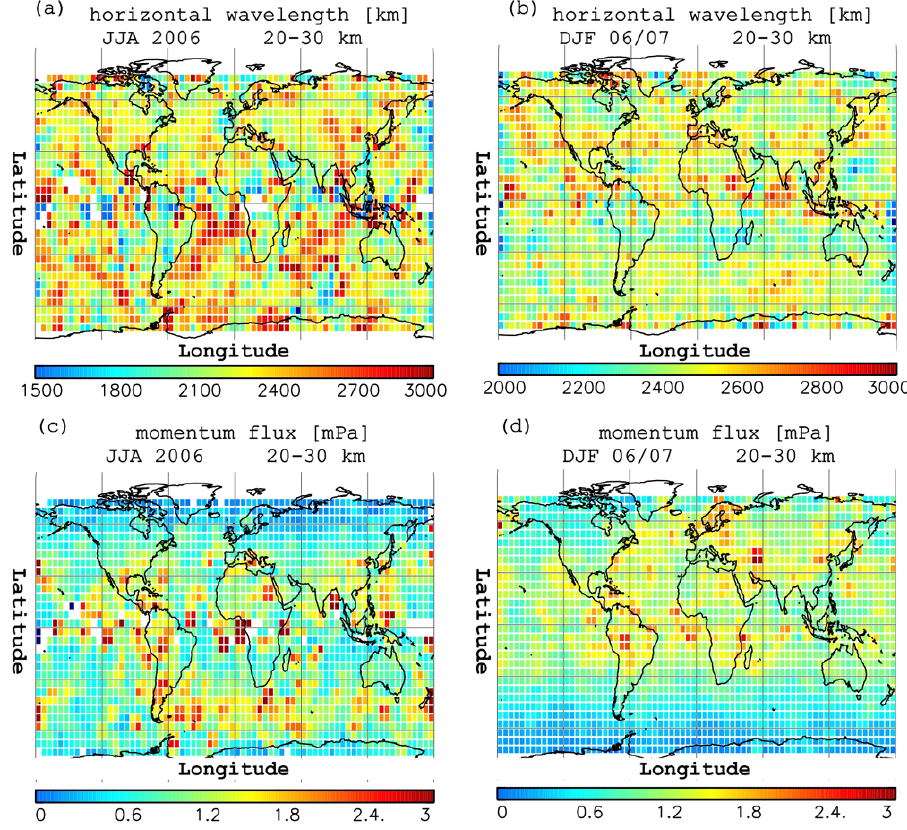
Fig. 10. Horizontal wavelength derived from 3 points of COSMIC temperature profiles for the available 3 points (JJA 2006) ( a ) and (DJF 2006/07) ( b ), and the mean momentum flux distribution respectively for each season ( c and d ) for the altitude range of